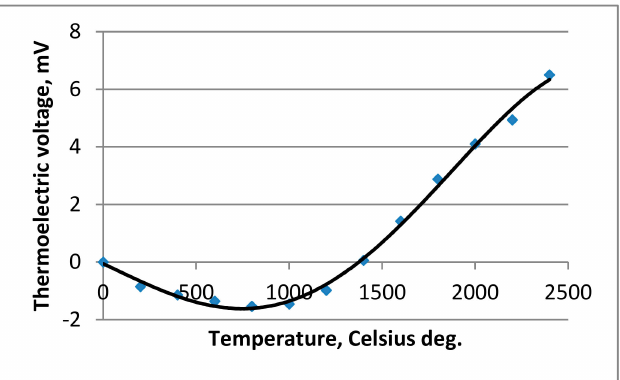
Figure 4. Characteristics of the non-standardized thermocouple W-Mo with a temperature range up to 2400 ◦ C